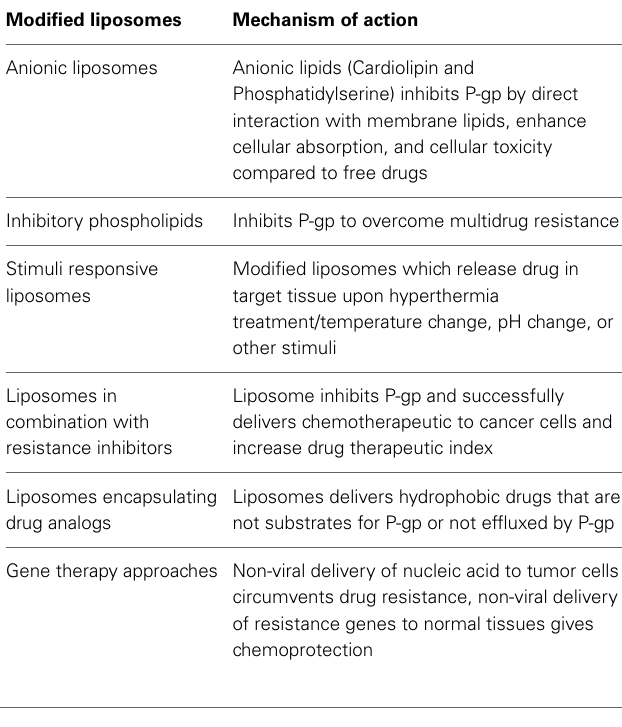
Table 4 | Marketed liposomal delivery systems to overcome drug resistance. Marketed